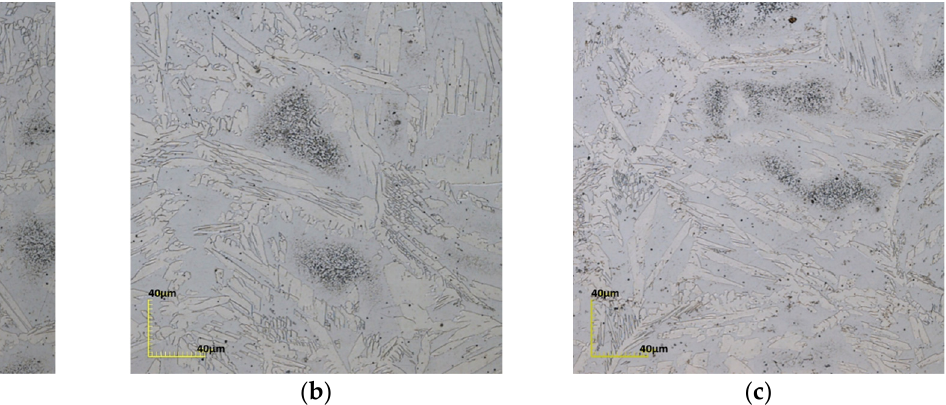
Figure 5. Representative microstructure found in the HAZ. Electrolytic etching with 10% oxalic acid. Confocal microscopy (model Olympus OLS400, Shinjuku, T ó quio, Jap ã o), 1075 × magnification.